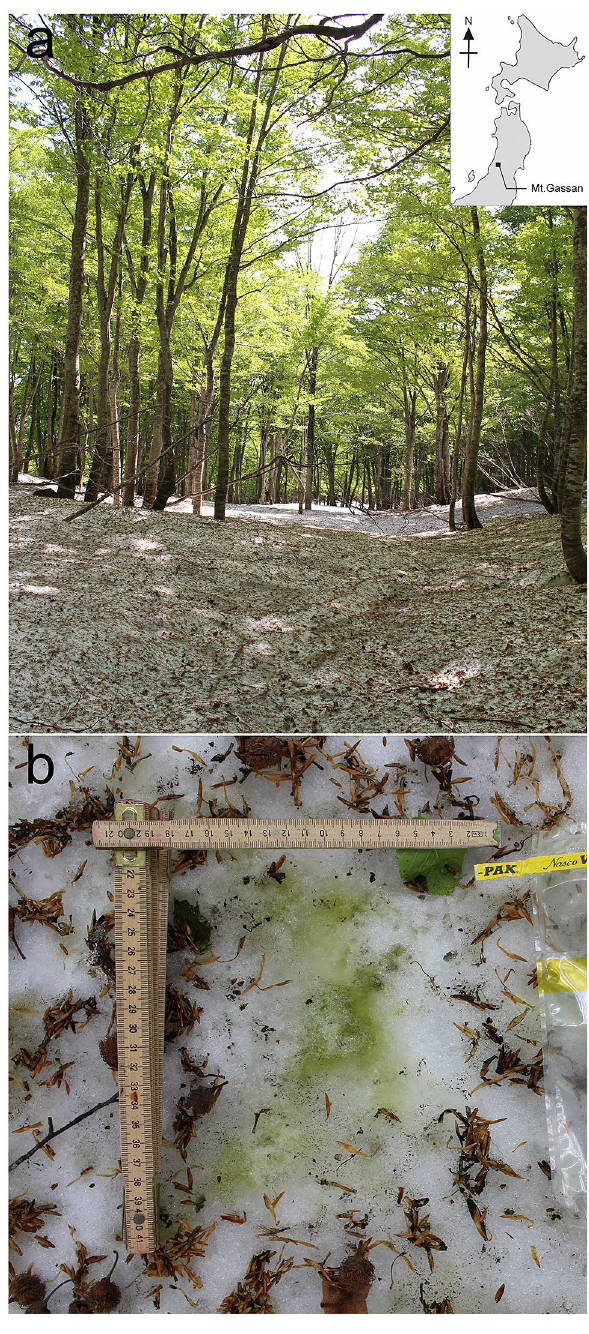
Figure 1. ( a ) Sampling area in May, 2019. Leaf of beech trees have already been opened. ( b ) Green snow patches collected in May,